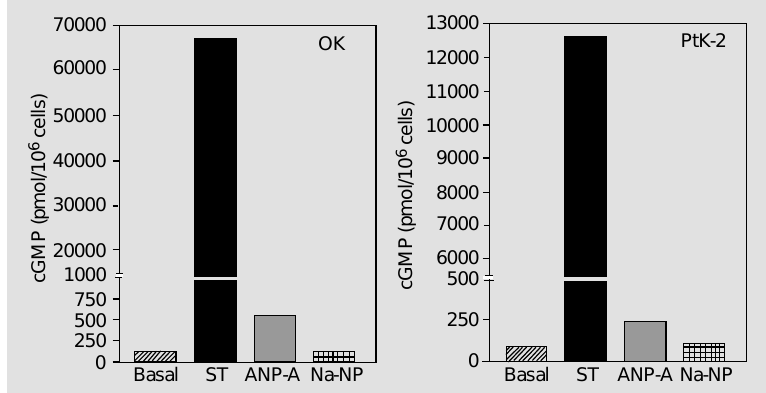
Figure 1 - Activation of surface receptors on OK and PtK-2 cells by Escherichia coli stable toxin (ST) and atriopeptin-A. Confluent cells were treated for 15 min at 37 o C in DMEM- HEPES-MIX with 0.5 µM ST, 0.1 µM atriopeptin-A (ANP-A) or 1 mM sodium nitroprusside (Na-NP). The data are reported as the mean of 4 experiments with opossum kidney (OK) cells and 2 experiments with potoroo kidney (PtK-2)